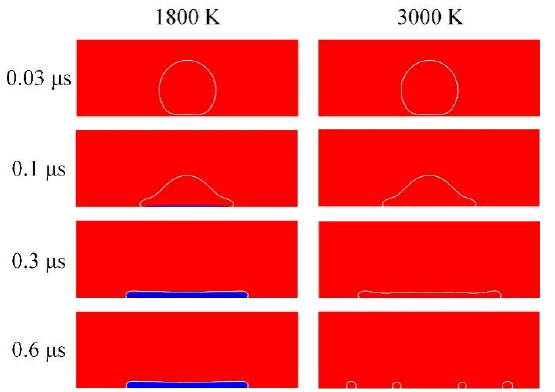
Figure 7. Evolution of spreading and solidification for Ni drop at different initial temperatures. The white iso-contour is of c = 0.5 and the blue indicates the frozen portion.